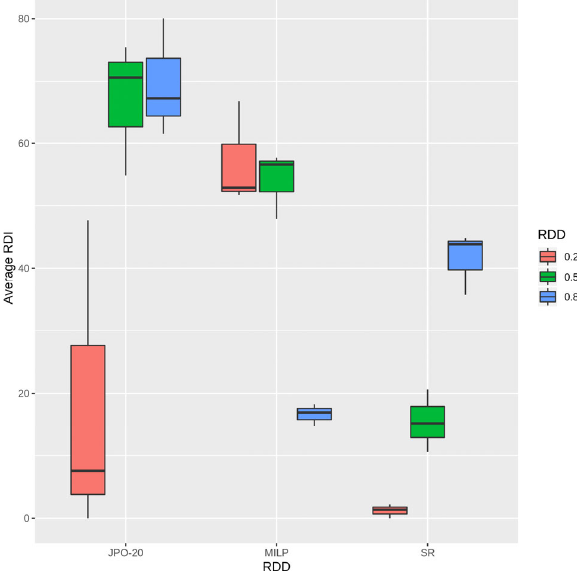
Fig. 6. Boxplots for average RDI values depending on